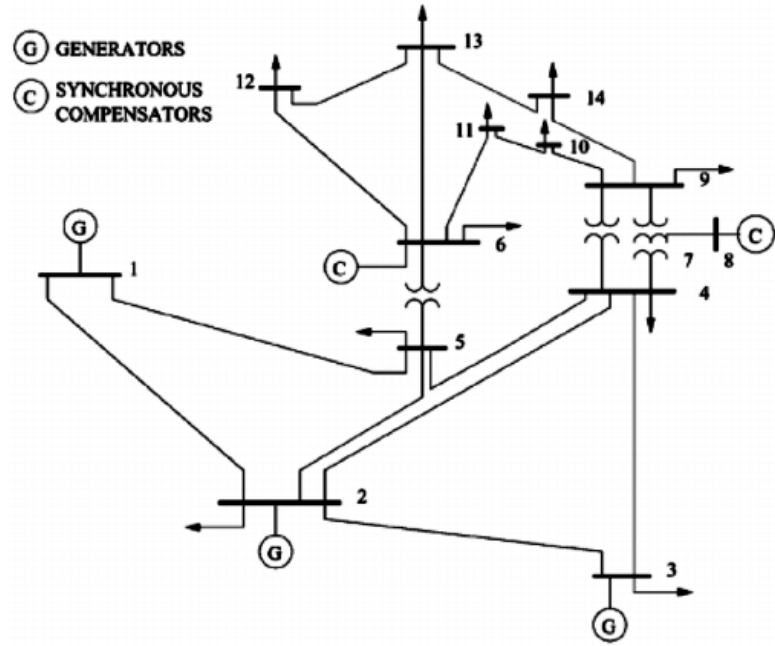
Figure 9. IEEE 14-bus test system [36].